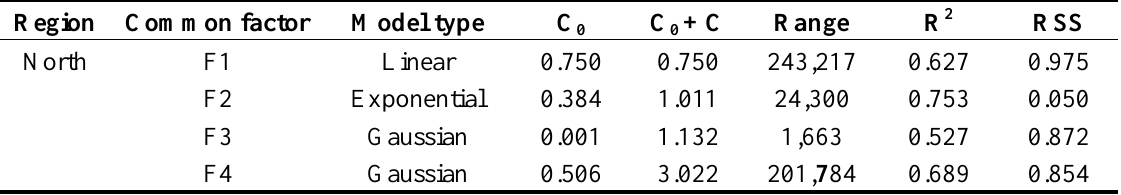
Table 4. Variography results for factor